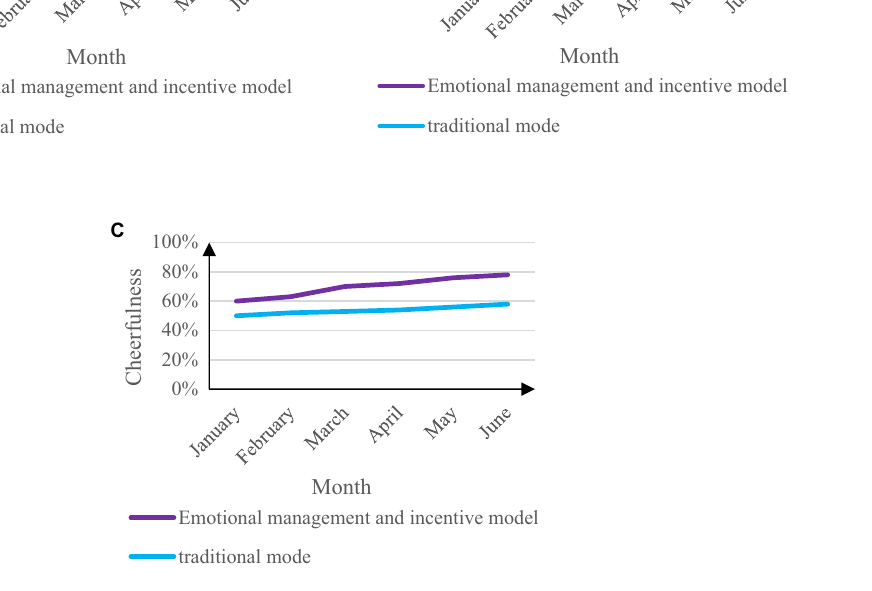
FIGURE 10 Comparison of students’ cheerfulness. (A) The degree of cheerfulness of freshman students. (B) The degree of cheerfulness of sophomore students. (C) The degree of cheerfulness of the third-year students.